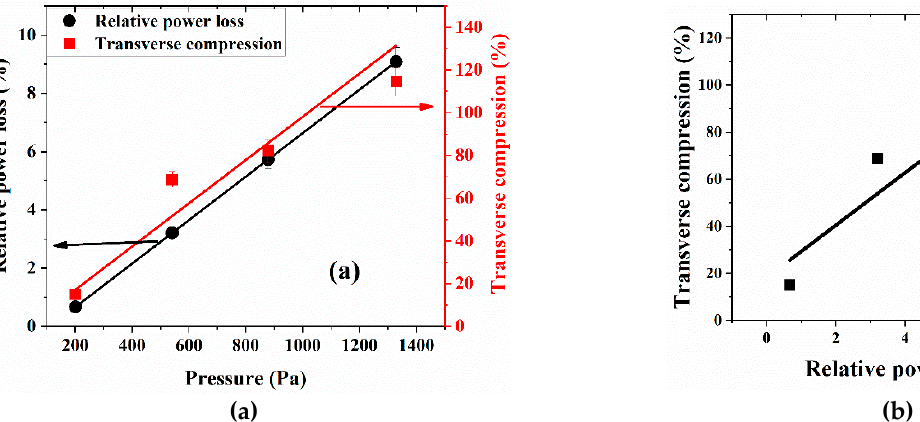
Figure 8. ( a ) Variation of power loss and transverse compression with respect to applied pressure. ( b ) Sensor relationship between the transverse compression as a function of the relative power loss.